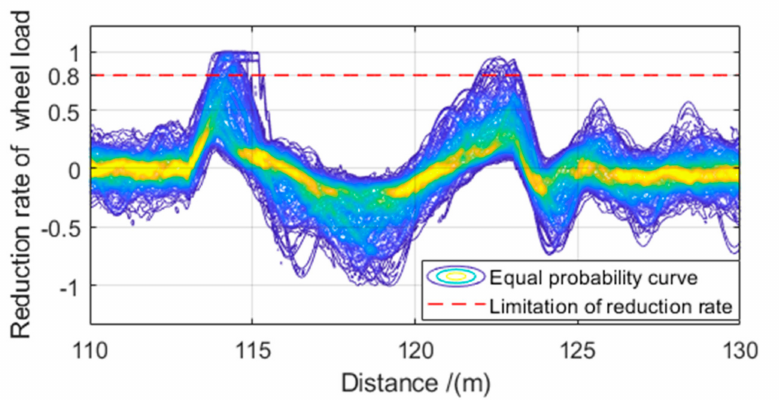
Figure 13. Equiprobability curve of the reduction rate of wheel load when the variation coefficient is 0.2.